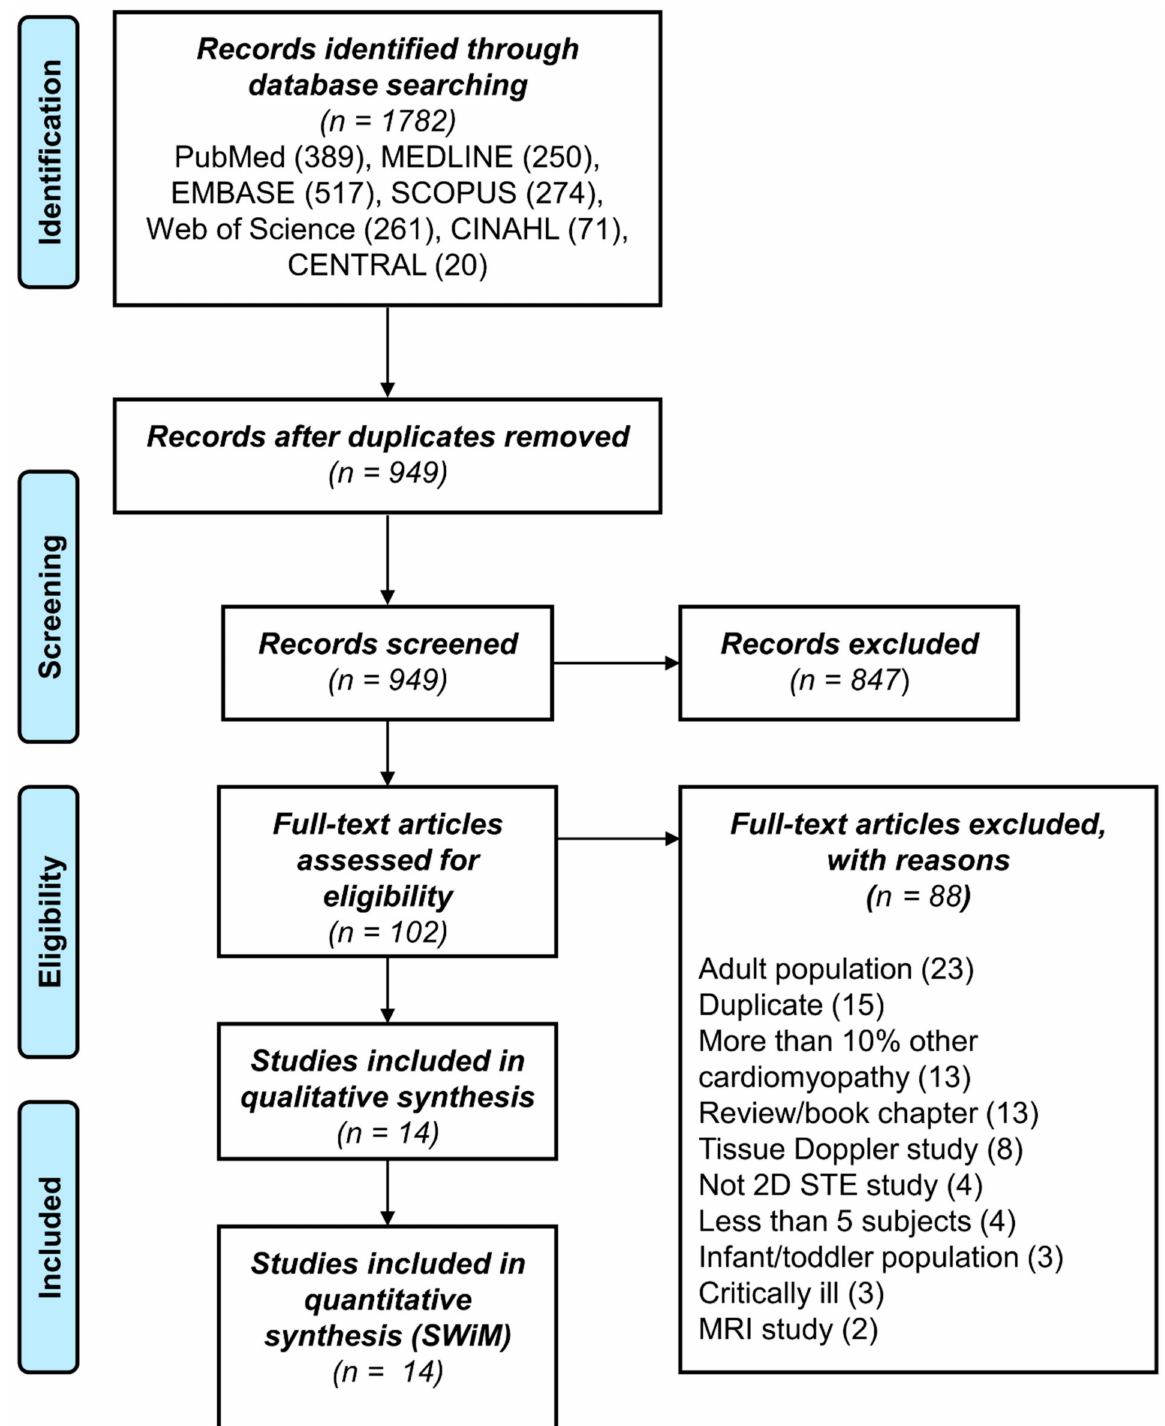
Figure 1. PRISMA flowchart of screened, included and excluded